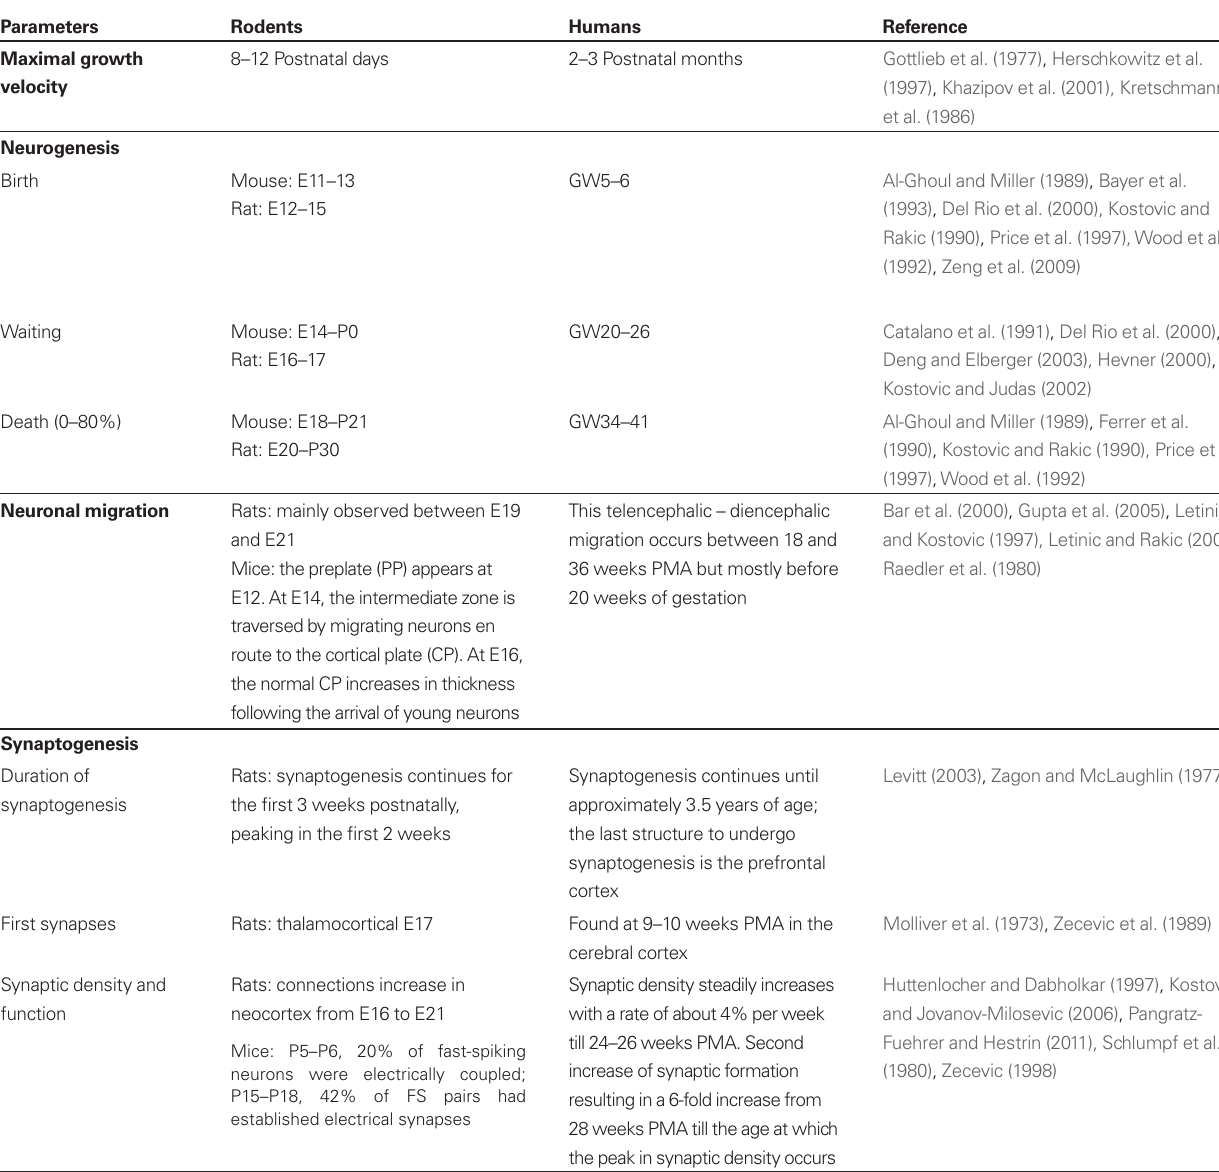
Table 1 | Comparative development of the cortex between laboratory rodents and humans using various